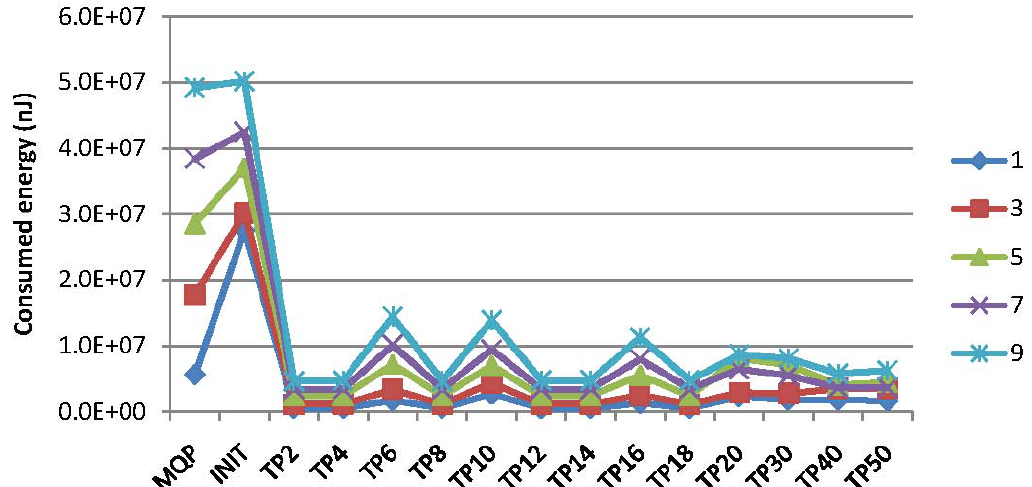
Figure 11. Comparison of energy consumption of our popularity-based cooperative caching (PCC) and multiple-attribute query processing (MQP) [33] for the query types of MAQWR and SAQWR, where the number of attributes is set to 1, 3, 5, 7 and 9, respectively. The energy consumption at various time points (TP2, TP4, etc .) are illustrated. Generally, the energy consumption of our PCC is much smaller than that of MQP (roughly 30% less on average for PCC than MQP), especially when the number of query attributes is relatively large. Note that the energy consumption of PCC is quite large at the first time point, since no sensory data have been cached in the SN for reducing the data gathering from the network in real-time to facilitate the query processing.